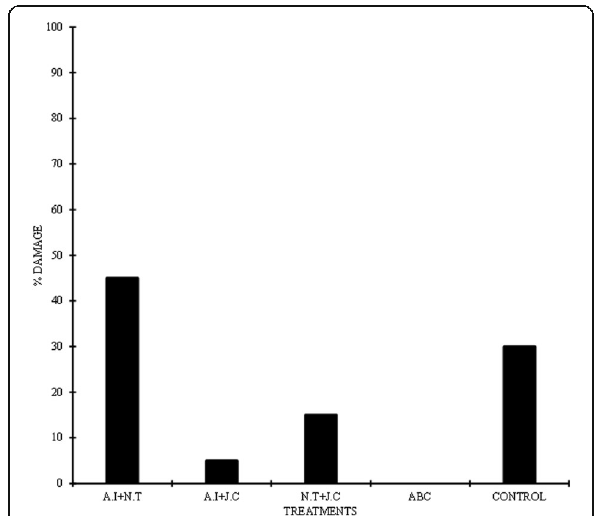
Fig. 7 Visual rating (%) of extract-treated wood exposed to Macrotermes subhyalinus in the open field after 12 weeks. A.I+N.T = Azadirachta indica plus Nicotiana tabacum. J .C+A.I = Jatropha curcas plus Azadirachta indica. N .T+J.C = Nicotiana tabacum plus Jatropha curcas. A BC = Azadirachta indica plus Nicotiana tabacum plus Jatropha curcas